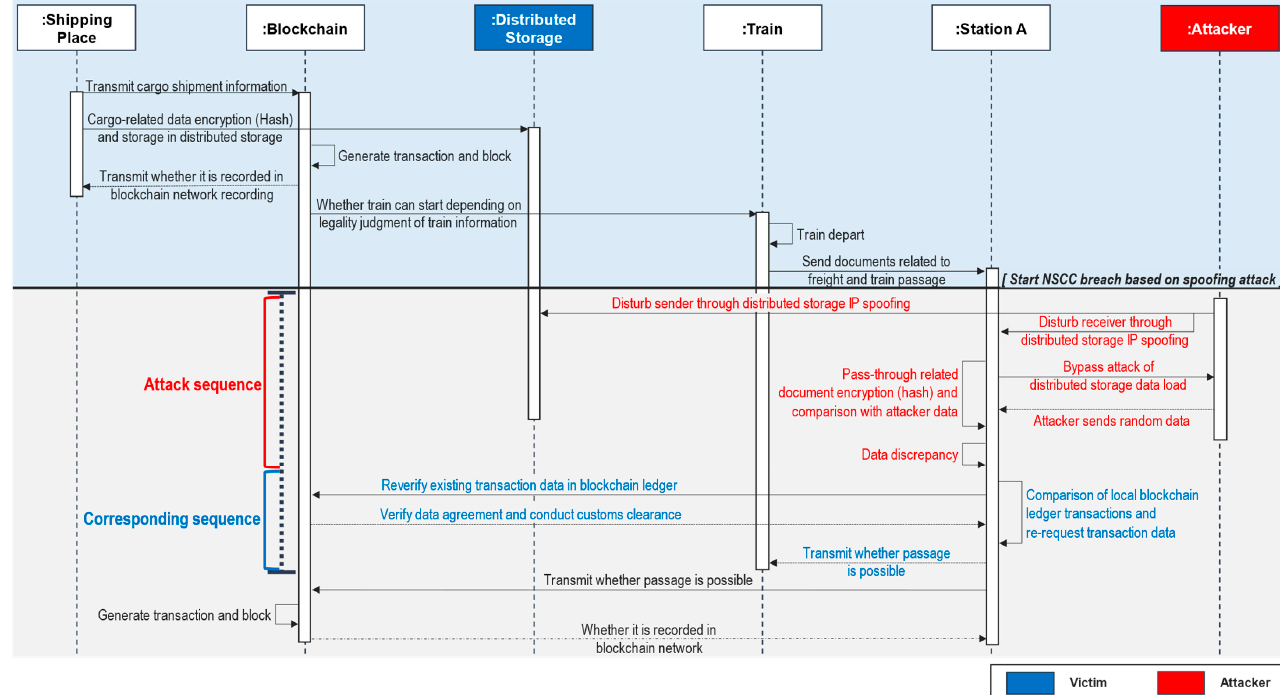
Figure 7. Attack sequence diagram using spoofing.